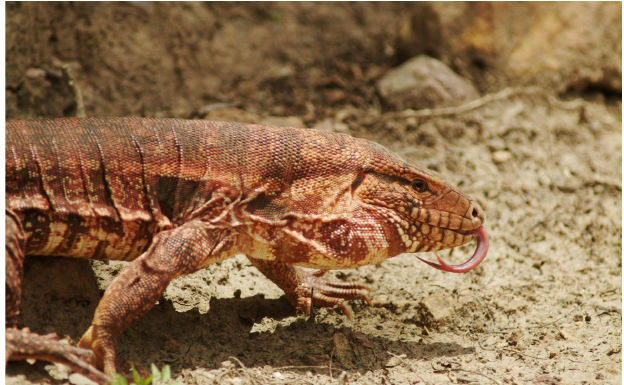
(photo voucher SMF-F 237)